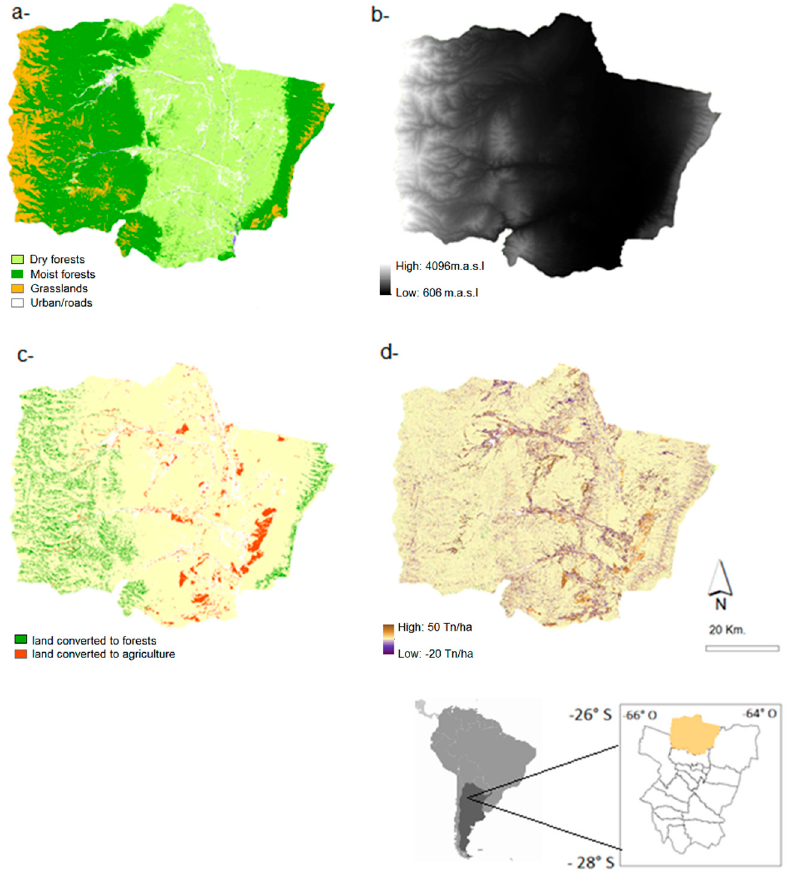
Figure 1. Study area, including ( a ) ecoregions; ( b ) digital elevation model; ( c ) land cover change (based on Nanni and Grau, 2014); and ( d ) soil retention change between 1986 and 2006. Bottom right: limits of Argentina within South America and of Trancas Department within Tucumán province.